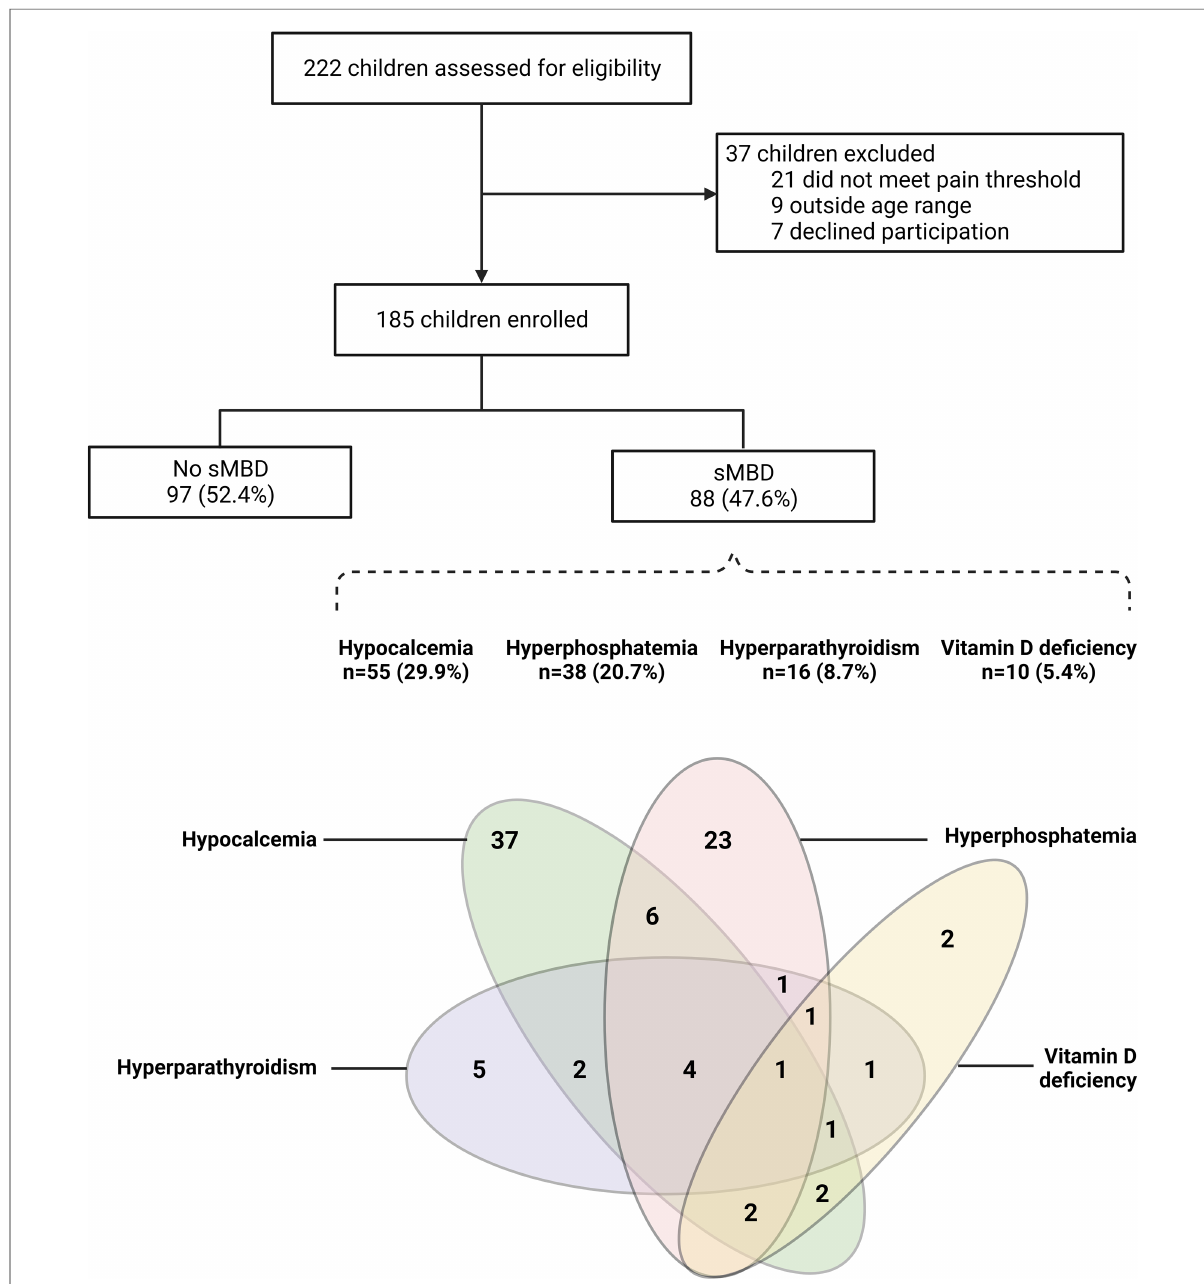
FIGURE 1 Flowchart of the study population. Flow chart depicting study participants based on sickle cell anemia related mineral bone disorder (sMBD). Below the fl owchart is a Venn diagram showing the inter-relationships between parameters used to de fi ne sMBD with hypocalcemia (corrected calcium <2.2 mmol/L) present in 55 children (29.9%), hyperphosphatemia (phosphate levels>upper limit of normal for age and sex) present in 38 children (20.7%), hyperparathyroidism (parathyroid hormone >70 pg/ml) present in 16 study participants (8.7%) and Vitamin D de fi ciency (<30 nmol/L) present in 10 (5.4%) of study participants. Created with